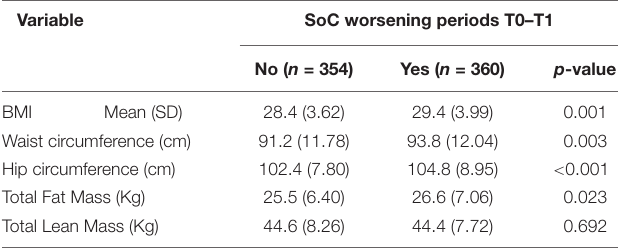
TABLE 4 | Body composition and SoC worsening between periods T0 and T1: Bivariate